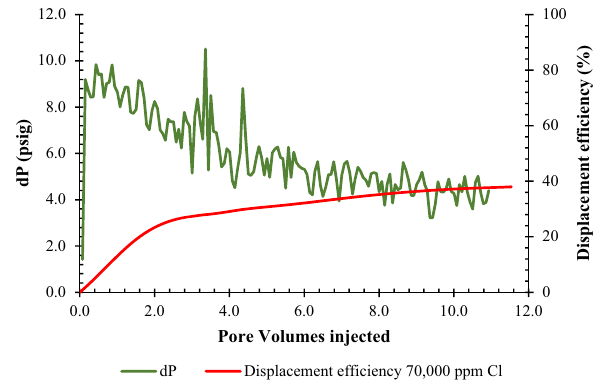
Fig. 8 Displacement efficiency of high-salinity sulphate brine